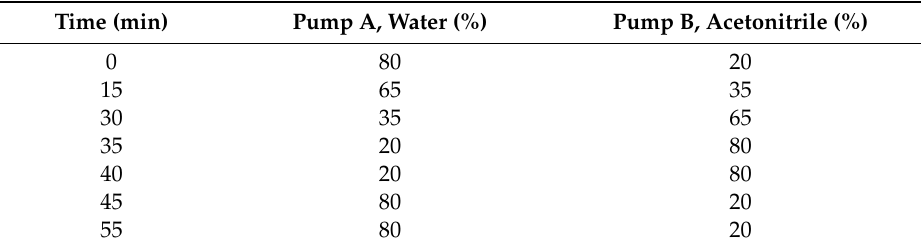
Table 6. Gradient condition for